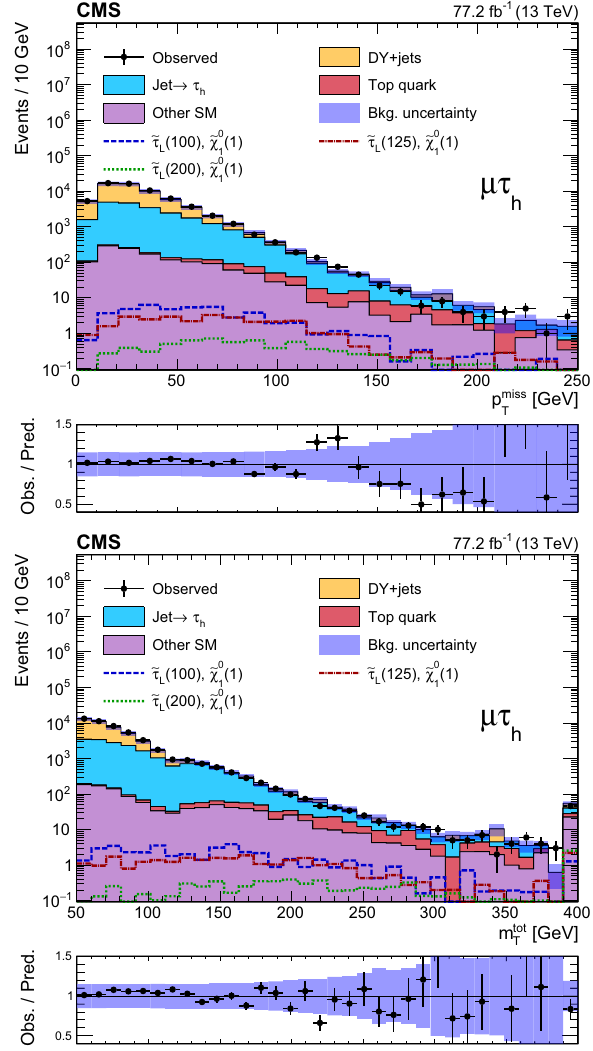
Fig. 3 Distributions in p miss (upper) and m tot (lower) for events in T T the combined 2016 and 2017 data passing the baseline selections in the μτ final state, along with the corresponding prediction for SM h background and three benchmark models of (cid:2) τ L pair production with ) = 1GeV. The numbers m ( (cid:2) τ L ) = 100, 125, and 200GeV and m ( (cid:2) χ 0 1 within parentheses in the legend correspond to the masses of the (cid:2) τ L and (cid:2) χ 0 in GeV. The last bin includes overflow events in each case. The 1 shadeduncertaintybandsrepresentthecombinedstatisticalandaverage systematic uncertainties in the background